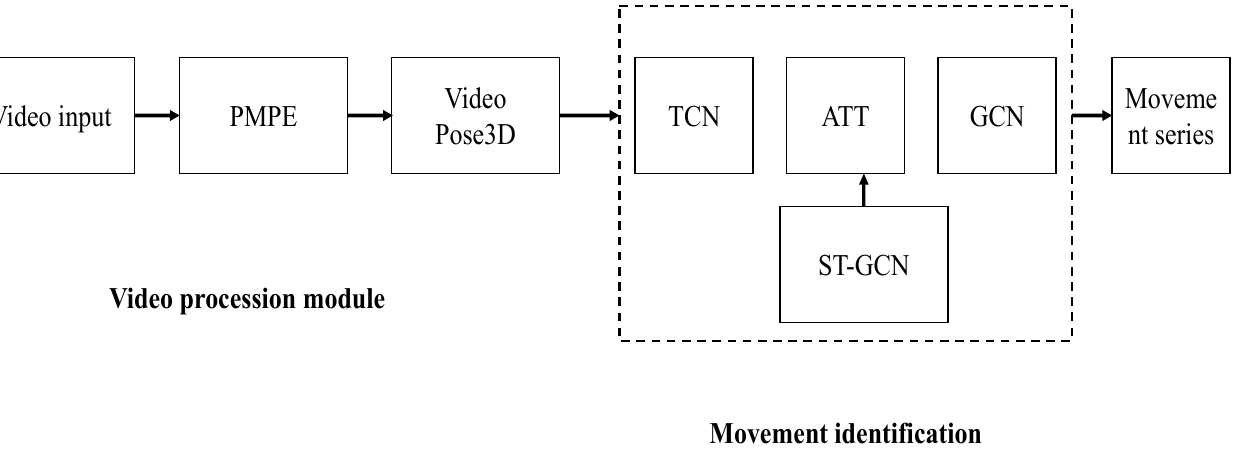
Figure 2. Action recognition overall architecture diagram.